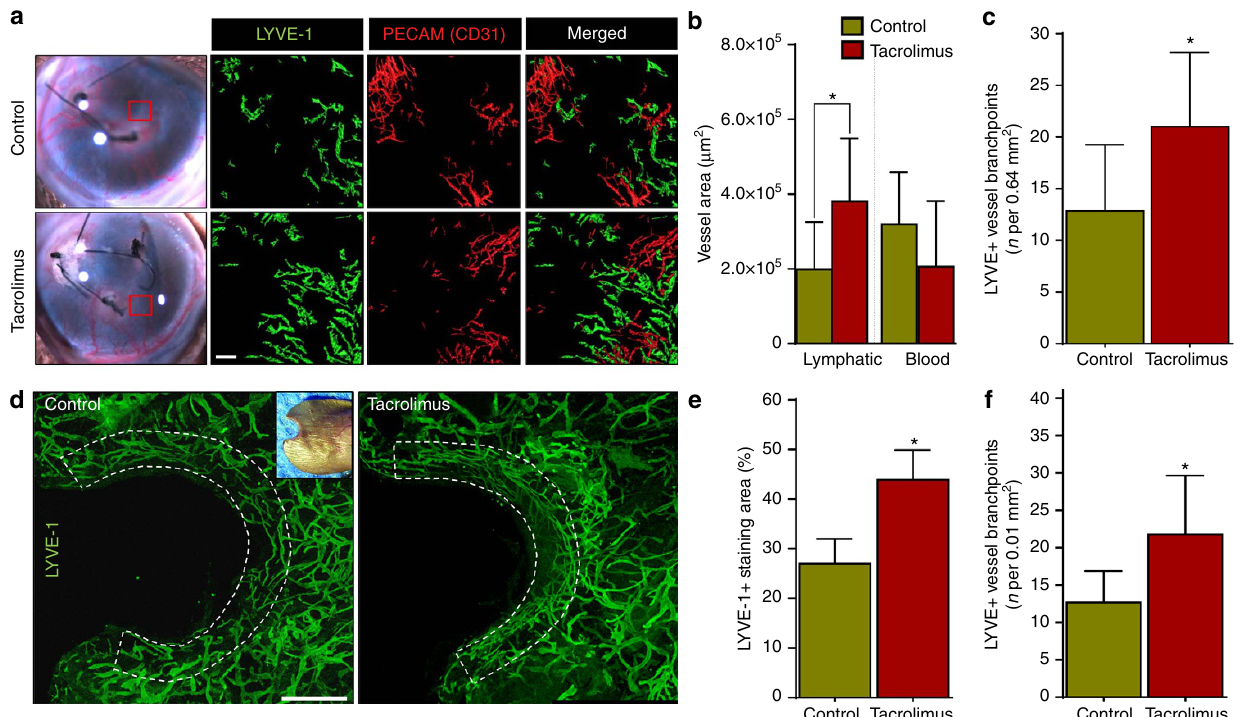
Figure 6 | Tacrolimus increases inflammatory lymphangiogenesis. ( a ) Representative gross (left panels) and whole-mount (cid:3) 5 images (right panels) of mouse corneas stained for lymphatic vessels (High LYVE-1 þ /low CD31 þ , green) and blood vessels (CD31 þ /LYVE-1 (cid:2) , red) harvested 2 weeks after suture placement and treatment either with vehicle control or systemic tacrolimus. Red box denotes area shown in whole-mount images. Scale bar, 100 m m. ( b ) Quantification of corneal lymphatic (LYVE-1 þ ) and blood (CD31 þ /LYVE-1 (cid:2) ) vessels (* P ¼ 0.032, n ¼ 6/group). ( c ) Quantification of lymphatic vessel branch points per 0.64mm 2 area (four random areas/mouse) in suture placed cornea treated with or without tacrolimus demonstrating increased branching in tacrolimus-treated animals ( P ¼ 0.033; n ¼ 6/group). ( d ) Representative immunofluorescent whole-mount (cid:3) 5 images of ear wounds localizing LYVE-1 þ in control or topical tacrolimus-treated animals harvested 4 weeks after wounding. Inset photograph shows area where sections were obtained. Scale bar, 800 m m. ( e ) Quantification of the LYVE-1 þ staining area in ear skin (within 400 m m of the wound) demonstrating an increase in lymphangiogenesis in tacrolimus-treated animals ( P o 0.001) ( n ¼ 6/group). ( f ) Quantification of lymphatic vessel branch points per unit area in ear wounds treated with or without tacrolimus, demonstrating increased branching in tacrolimus-treated animals ( P o 0.001; n ¼ 6/group). Experiments were repeated two to three times. All data represent mean ± s.d. with P r 0.05 considered as significant. Data analysed by two-tailed Student’s t